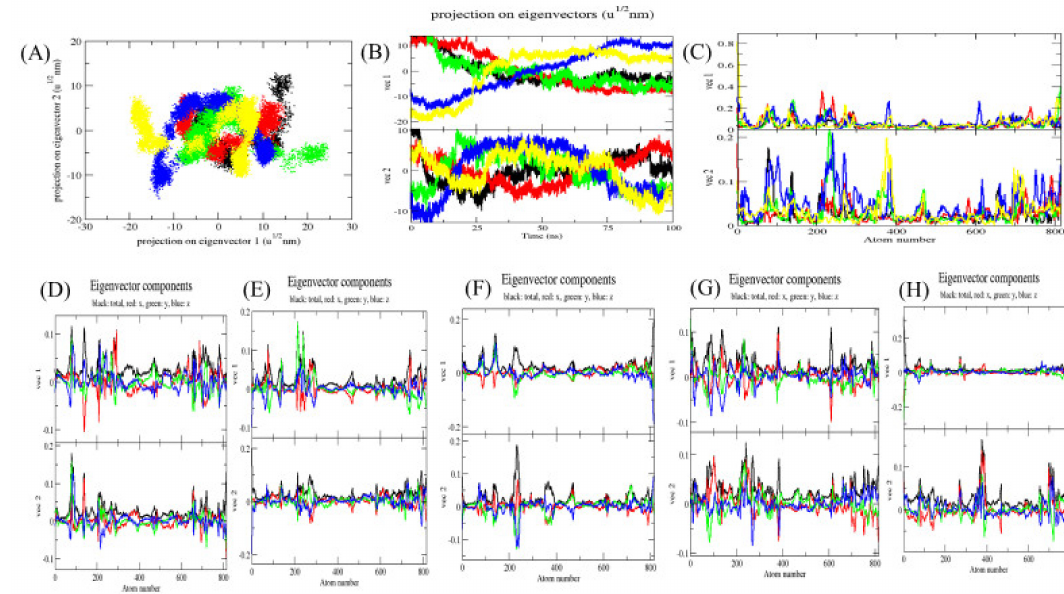
Figure 9. Principal Component Analysis. ( A ) The 2D projections of trajectories on eigenvectors showed different projections of Mrlip1. ( B ) The projections of trajectories on eigenvectors with respect to time. ( C ) Root mean square atomic fluctuations (RMSF) obtained during PCA calculations. Black, red, green, blue and yellow colour represent values obtained for Mrlip1, Mrlip1-RHC80267, Mrlip1-ZINC85530919, Mrlip1-ZINC95914464 and Mrlip1-ZINC85530320 respectively. The Eigenvector components were further resolved for Mrlip1 into total (black), x (red), y (green), and z (blue) directions for ( D ) Mrlip1, ( E ) Mrlip1-RHC80267, ( F ) Mrlip1-ZINC85530919, ( G ) Mrlip1-ZINC95914464, and ( H ) Mrlip1-ZINC85530320,